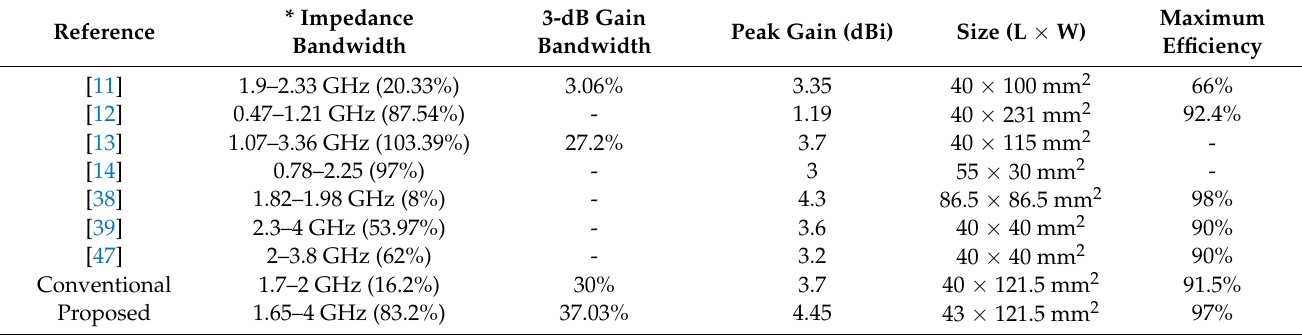
Table 2. Comparison between the proposed antenna and existing antenna